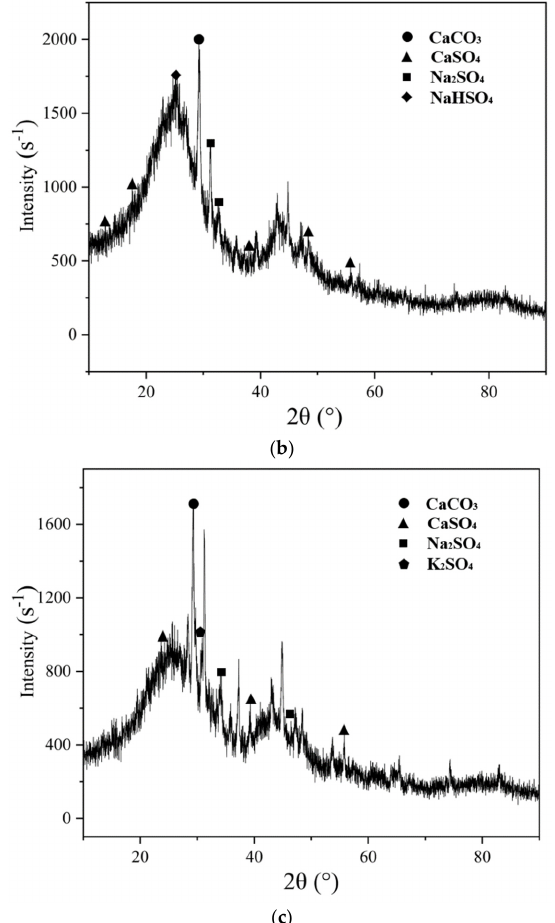
Figure 12. XRD pattern of activated coke after adsorption. ( a ) Unmodified. ( b ) 5% NH 3 modified. ( c ) 3% K 2 CO 3 modified.